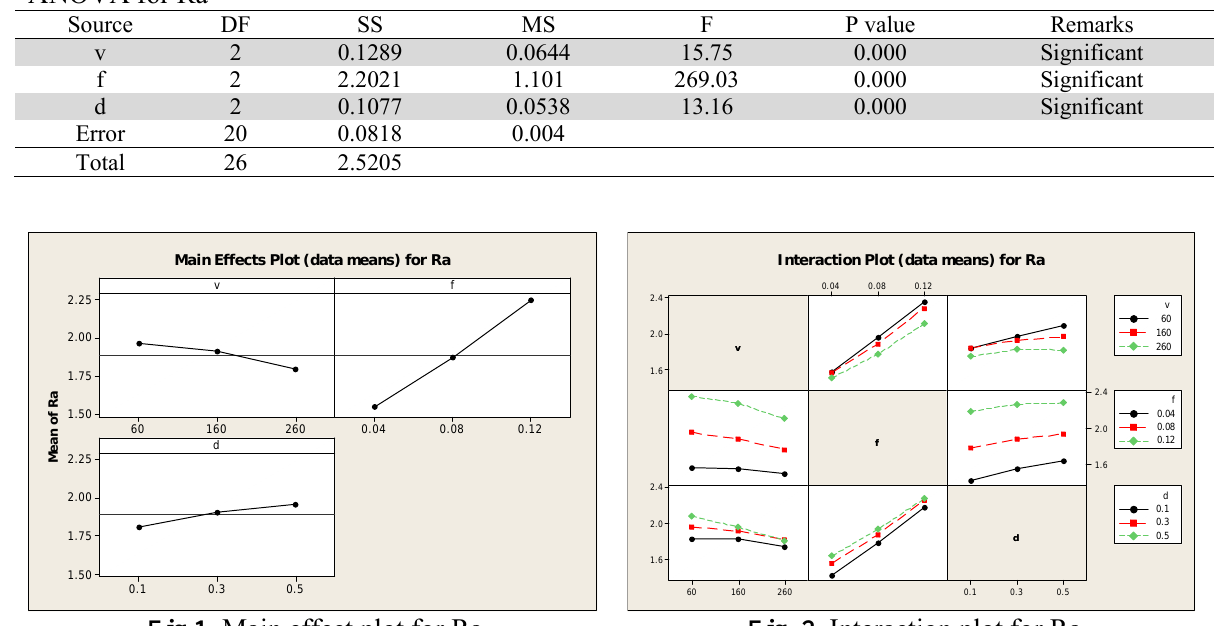
Fig.1. Main effect plot for Ra Fig. 2. Interaction plot for Ra